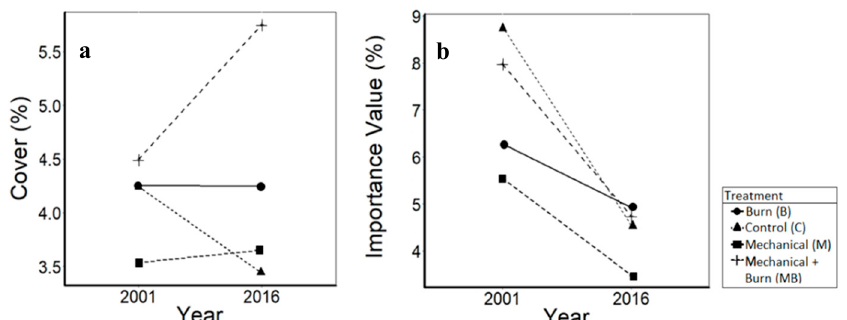
Figure 10. Forb primary guild ( a ) absolute cover (%) and ( b ) importance value results showing the 4 treatment e ff ects (control = C, burned = B, mechanical removal of stems < 10 cm in diameter at breast height (DBH) = M, and mechanical removal of stems < 10 cm DBH + burned = MB) from 3 analysis of variance (ANOVA). Post-hoc comparison (Tukey’s Honest Significant Di ff erence Test, THSD) letters show di ff erences between treatment e ff ects from 2001 to 2016.